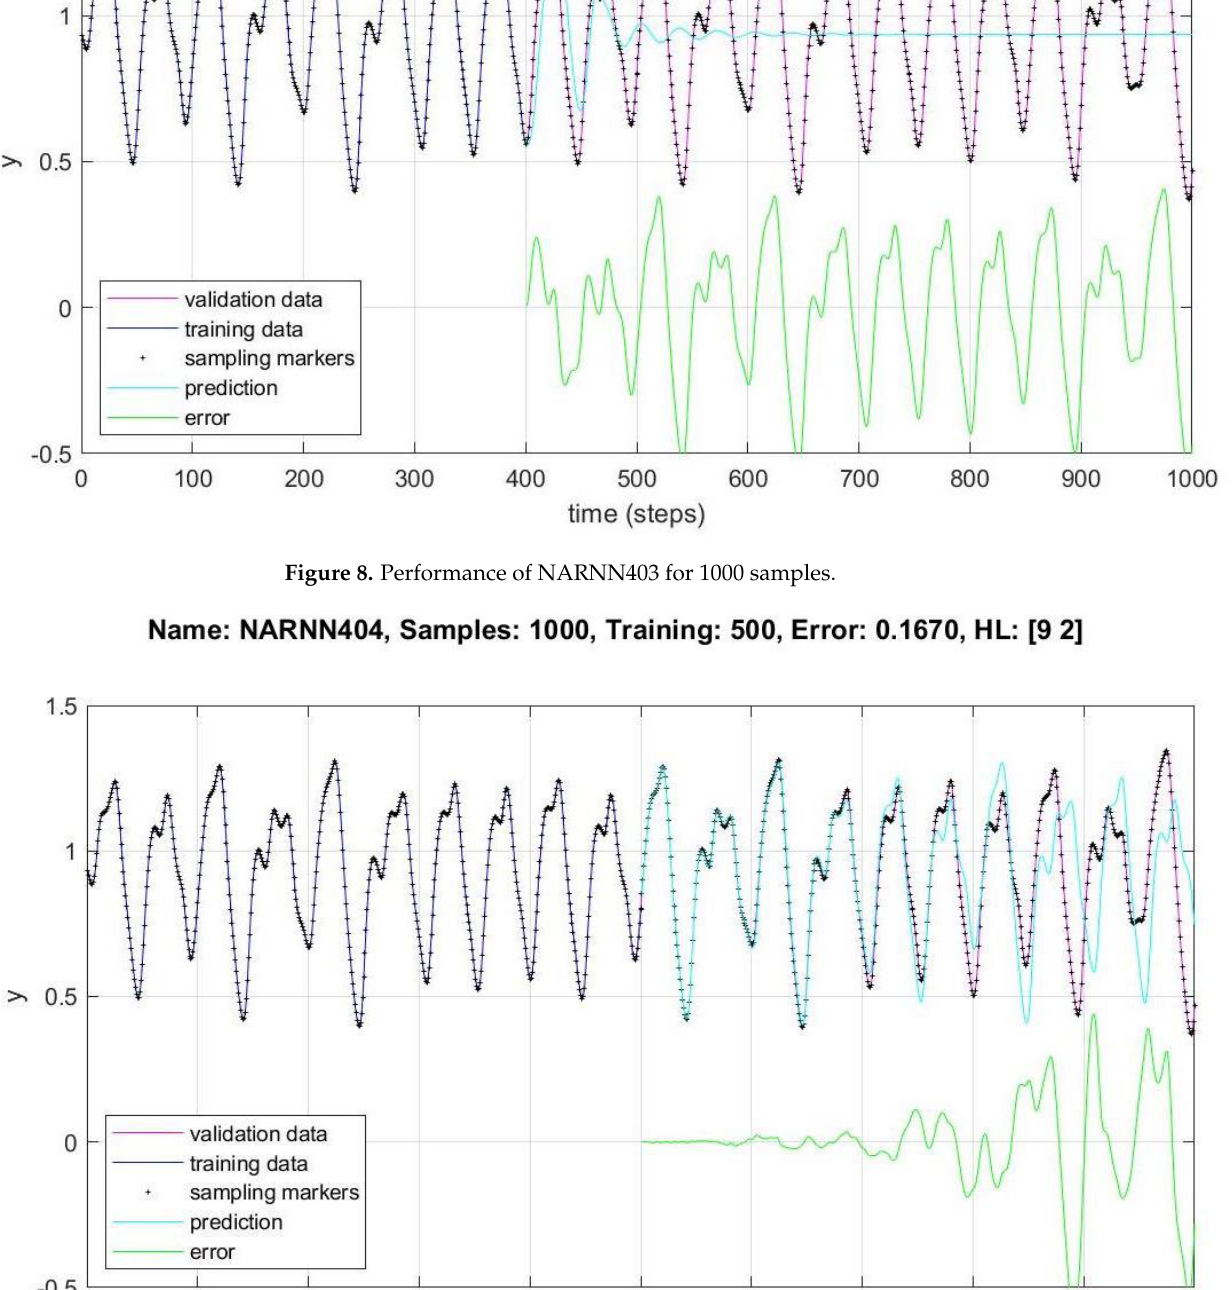
Figure 9. Performance of NARNN404 for 1000 samples.